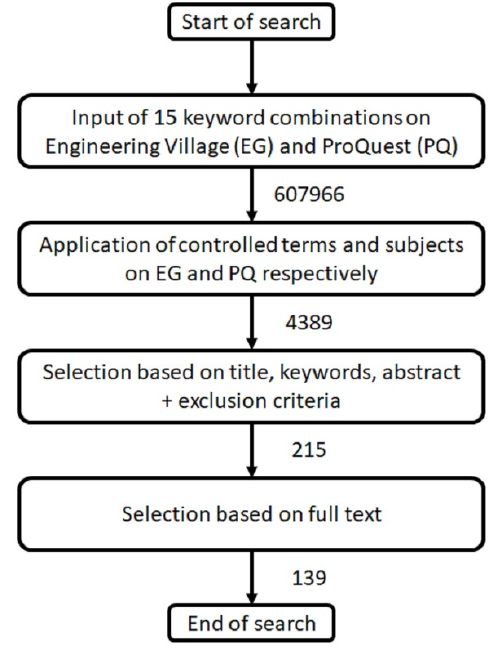
Figure 2. Selection process.